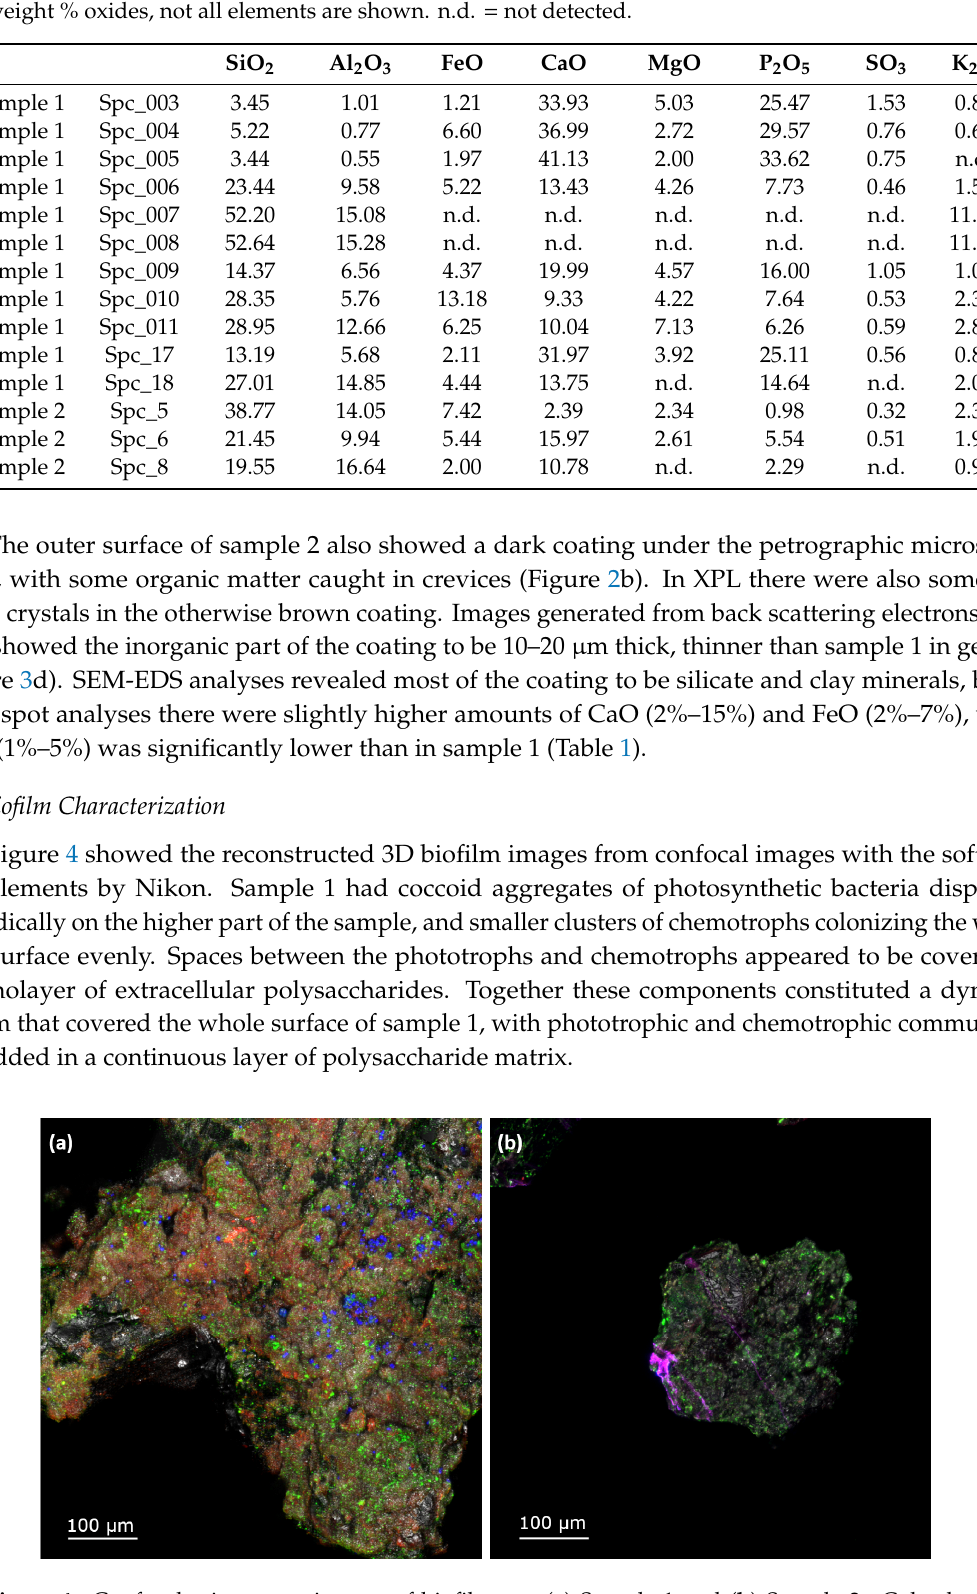
Figure 4. Confocal microscope images of biofilms on ( a ) Sample 1 and ( b ) Sample 2. Color key: phototrophs, blue (autofluorescence); chemotrophs, green (SYTO 9); polysaccharides, red (Con A); stone, gray (reflection).